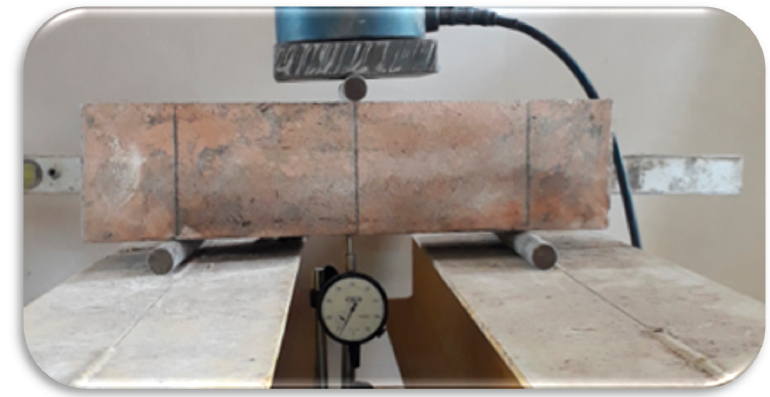
Figure 11. A sample of deflection determination for 1.0% V f at 400 ◦ C with gradual-cooling method. Fibers 2020 , 8 , 19 Table 10. Absorbed energy for all the adopted (RPC) mixes.